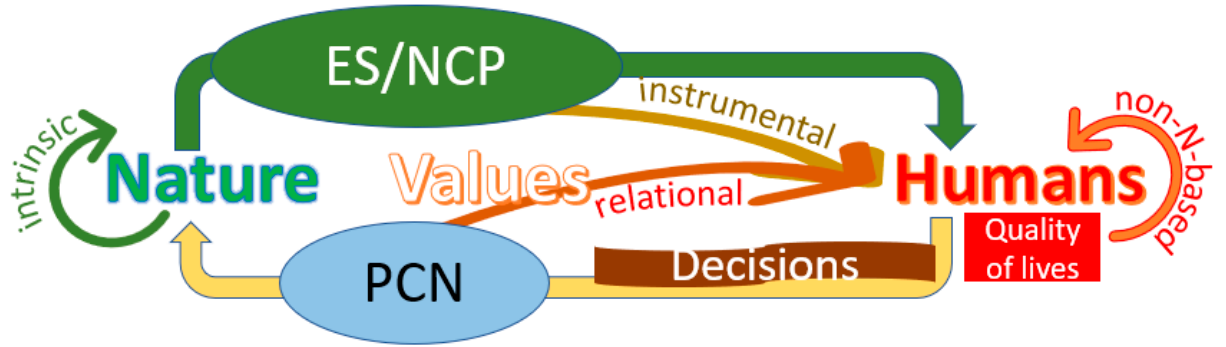
Figure 6. Interpretation of the complementarity of goal-oriented, instrumental and engagement-based, relational values of nature to humans, with respect to ecosystem services (ES) (or nature’s contributions to people, NCP) and people’s contributions to nature (PCN).